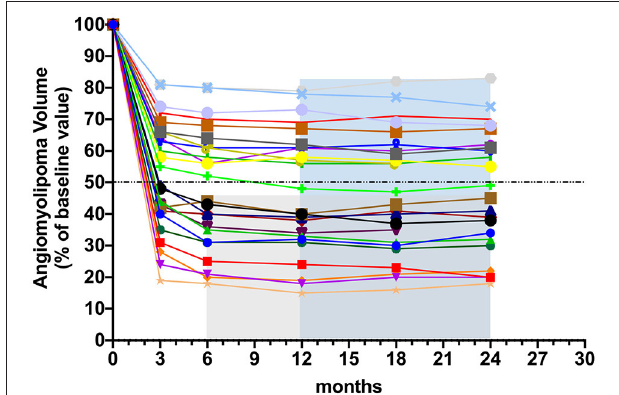
FIGURE 2 | Changes in TSC-RAML volume from baseline during the induction therapy and the maintenance therapy. Each line represents TSC-RAML volume change in one patient.